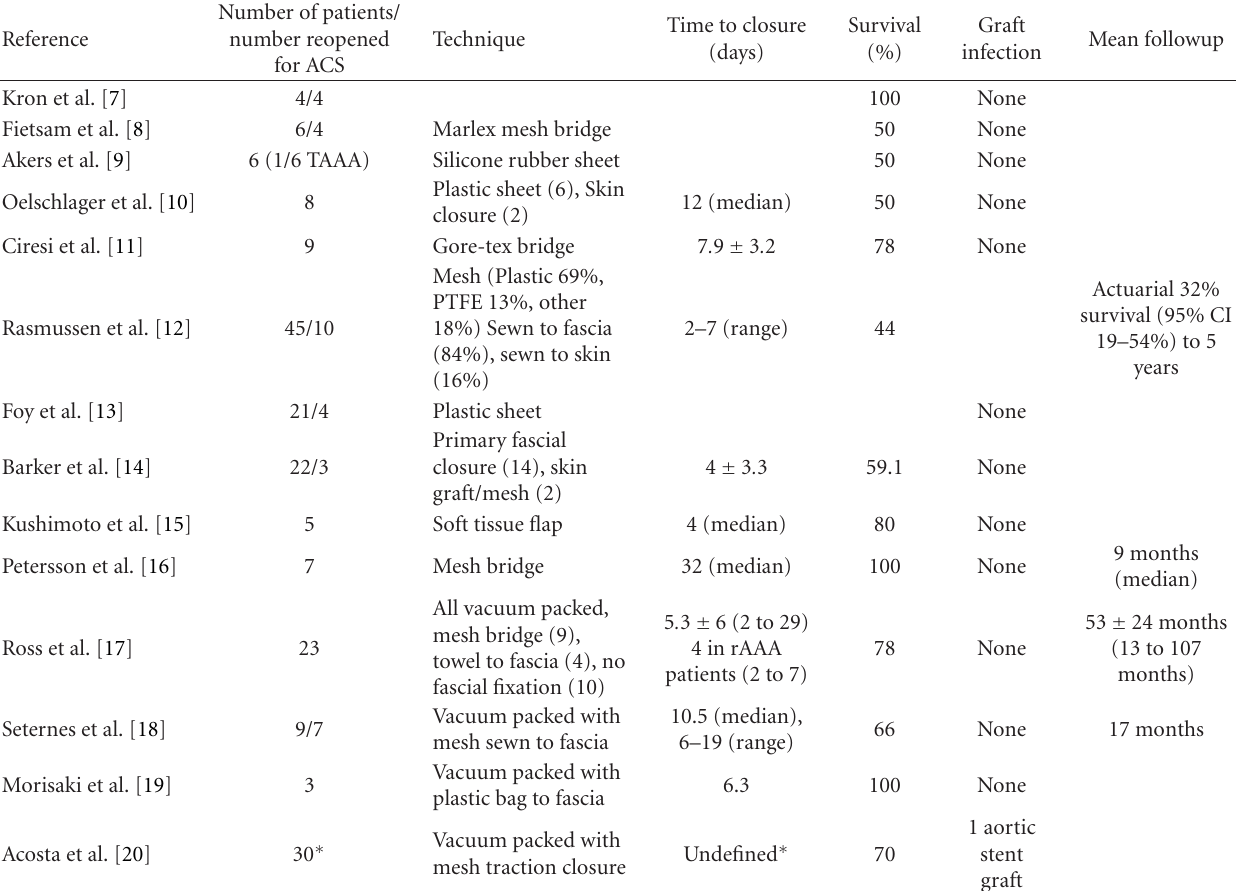
Table 3: Experience with open abdominal management following open repair of rAAA (adapted and updated from Ross et al. [17]).